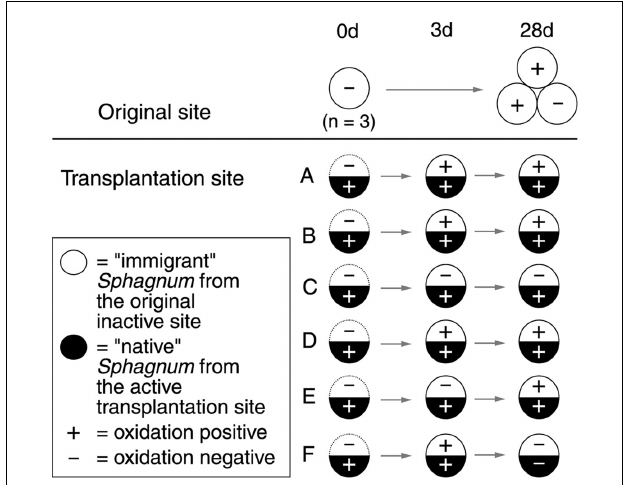
FIGURE 1 | Diagram of the transplantation experiment. CH 4 oxidation potentials at the time of sampling are included ( ± ; values over 0.005 μ molgdry mass − 1 h − 1 were considered positive). Dominant Sphagnum species on transplantation sites were S. papillosum (sites A–C), S. cuspidatum (sites D and E), and S. majus (site F).The original site O and the transplanted immigrant mosses consisted of S. rubellum